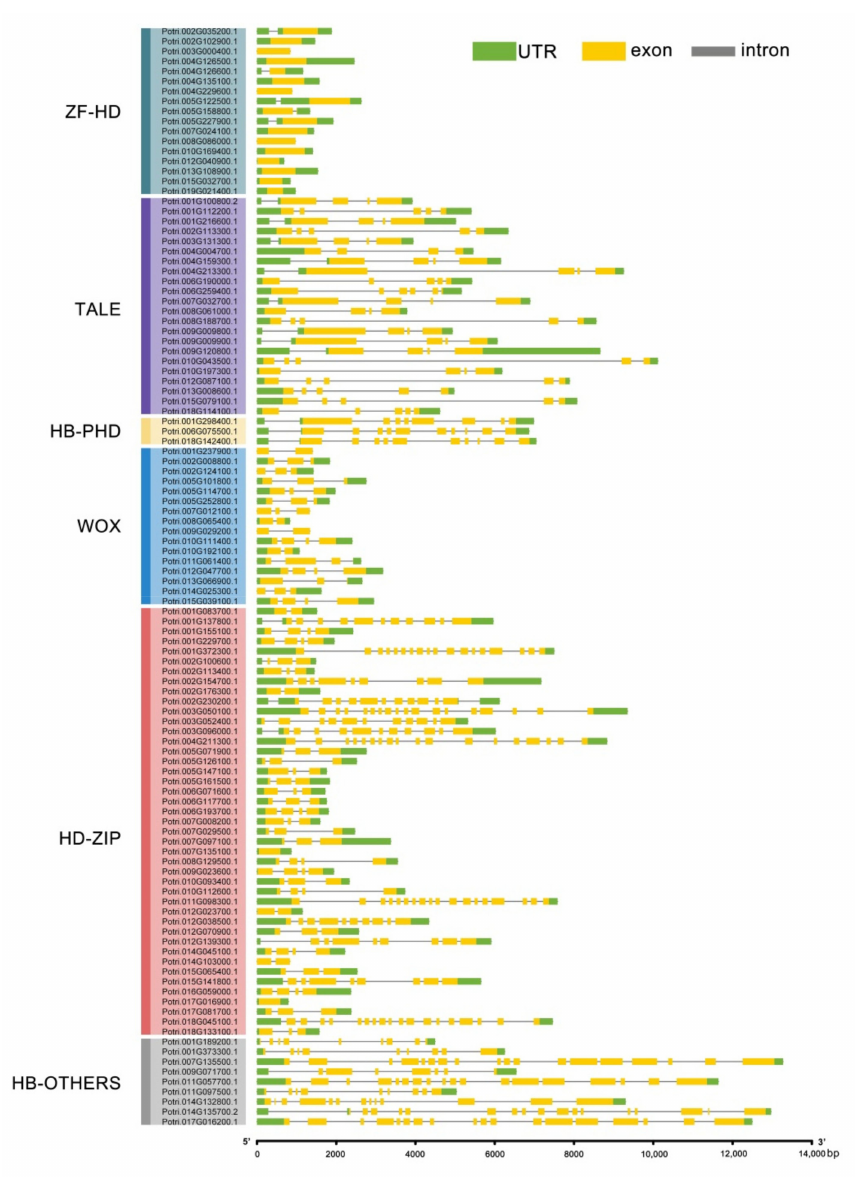
Figure 4. Structural analysis of PtrHB genes in P. trichocarpa. Introns, exons and UTR regions are represented by gray lines, yellow boxes and green boxes,